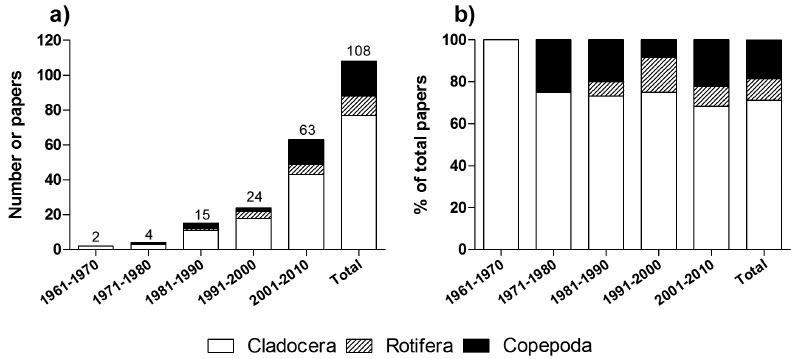
Figure 1. Scientometric analysis of the contribution of studies with the major zooplanktonic taxa to the research on stress, highlighting the prevalence of cladocerans over rotifers and copepods in number (a) and percentage (b) of published papers. For details on the methods used for the survey, please refer to the footnote 1